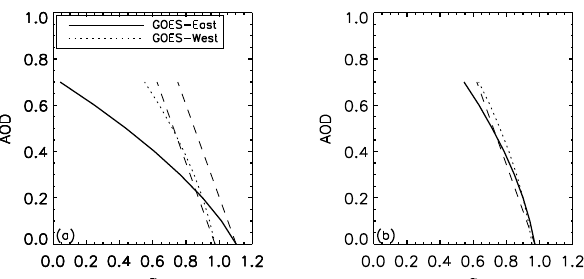
Fig. 6. AOD and surface reflectance solution curves for two satellite geometries at Boulder (a) 22:00UTC and (b) 20:00UTC, where a represents surface reflectance normalized by the previous day sur- face reflectance. The TOA reflectance was calculated using a = 0 . 9 and AOD=0.2. The long dashed lines have slopes of − 2. If a so- lution curve is to the right of the long dashed line, i.e. the absolute value of the slope of the curve is greater than that of the long dashed line, the TOA reflectance is not sensitive to the AOD variations, and vice